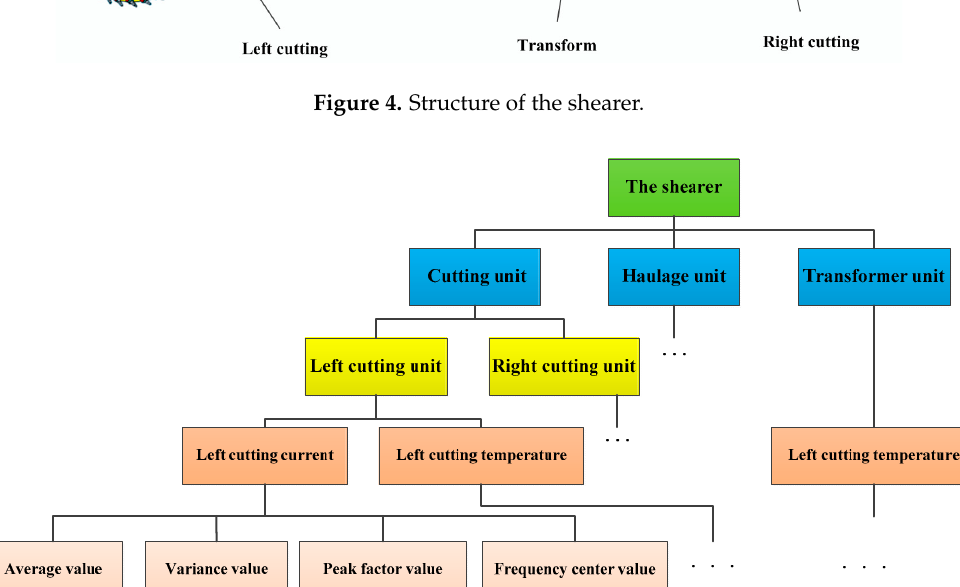
Figure 5. A multi-level state space for the shearer.